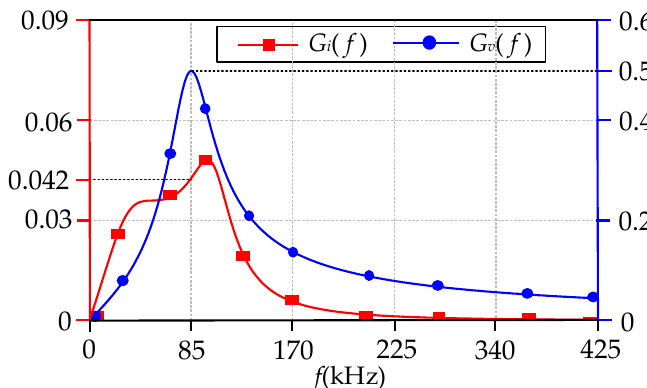
( b ) Figure 11. The waveforms of u ds and u C p versus C p values in Saber simulation. ( a ) The waveforms of u ds versus C p values; ( b ) the waveforms of u C p versus C p values. 0 0 14.2 Figure 12. Fourier decomposition diagram of the voltage u C p in Saber simulation. When all the circuit parameters are determined, the gain curve in the constant-cur-